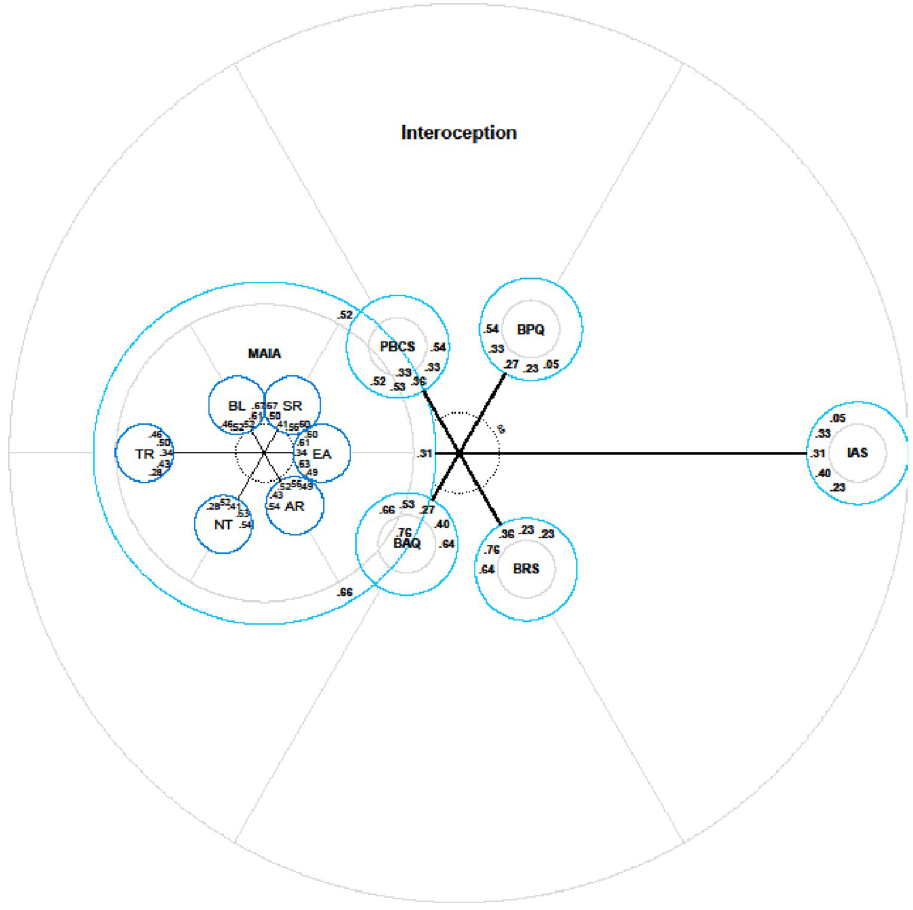
Fig 3. A nested model to demonstrate centre distances within MAIA-2 scales and across all of the measures of interoceptive sensibility. The position of the subscales within MAIA-2 cannot be interpreted relative to the other measures in the